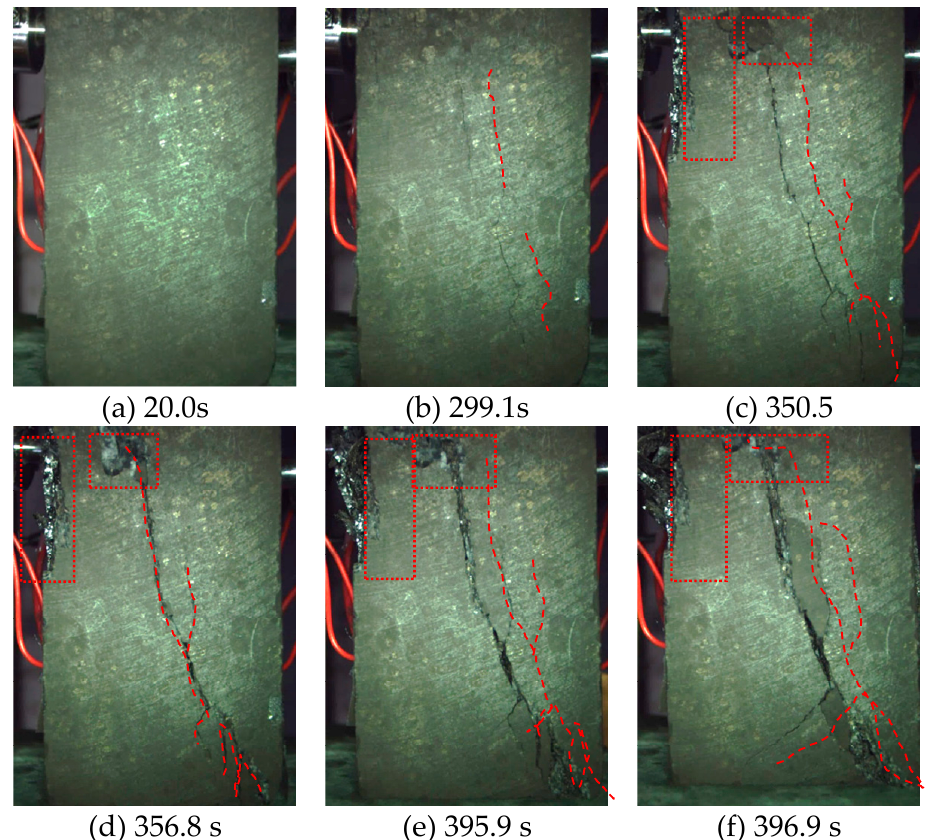
Figure 7. Pictures of fracture expansion in gas-bearing coal under load at different time moments; red imaginary lines refer to the tracks of crack expansion while red wireframes denote the centralized zone with cracks of specimen.